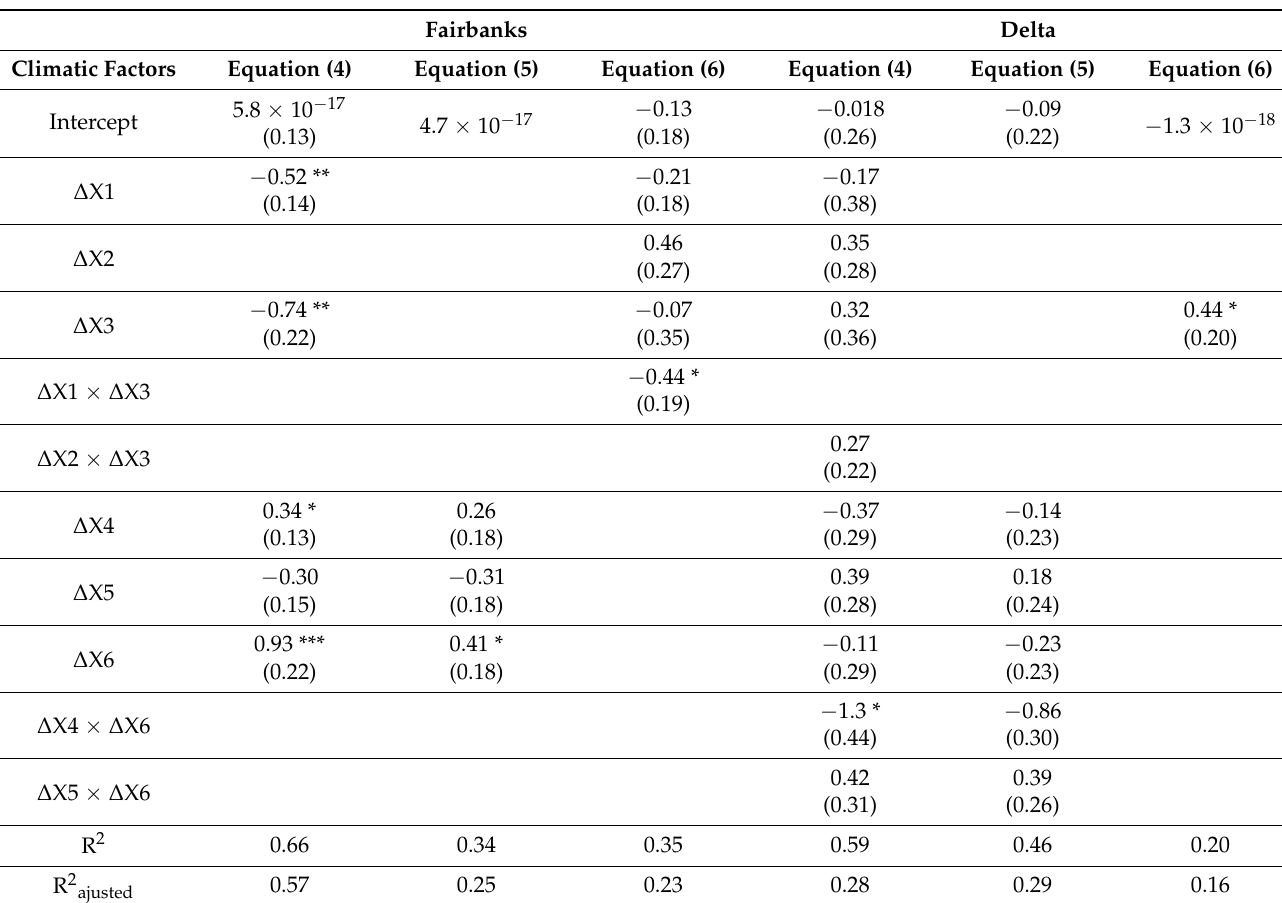
Table 4. The coefficients, R 2 , and R 2 ajusted of the best models for cultivar ‘Otal’ selected from Equations (4)–(6). The climatic factors are ∆ X1– ∆ X6 which represent ∆ TminBH, ∆ TdtrBH, ∆ PBH, ∆ TminAH, ∆ TdtrAH, and ∆ PAH at 10 days BH and AH,